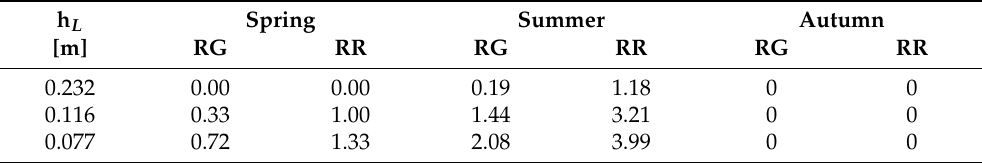
Table 2. Average number of hours per day where the medium temperature is larger than the critical temperature (35 ◦ C), for the two configurations (RG: raceway lying on the ground, RR: raceway raised above the ground) and for three water depths (h L